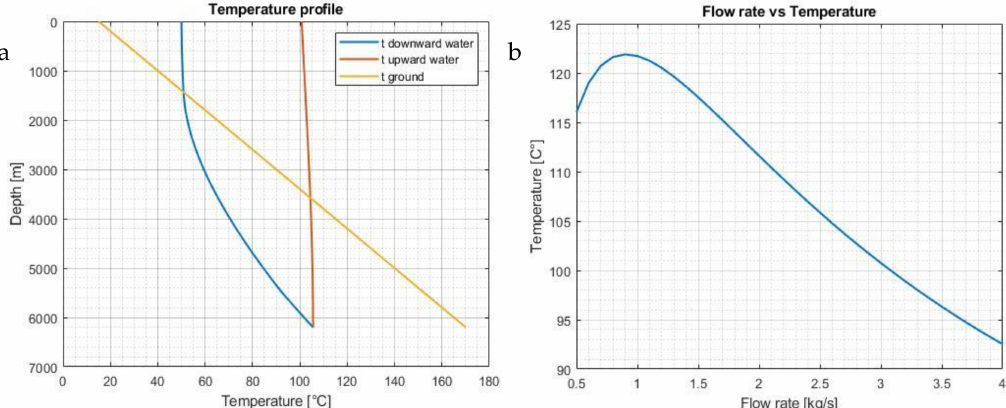
Figure 7. ( a ) Temperature profile associated with the coaxial WBHE configuration considering the site-specific stratigraphy of Villafortuna 1 well. ( b ) Wellhead temperature behaviour as the flow rate